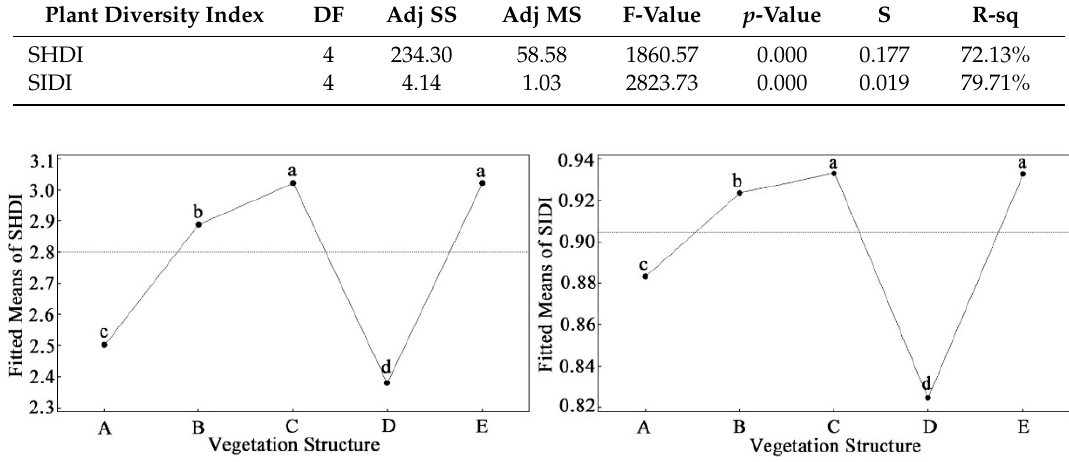
Figure 8. Differences of plant diversity index in green space with different vegetation structures. “A” represents open lawn green space, “B” represents semi-open lawn green space, “C” represents semi-closed single-layered broadleaved forest, “D” represents closed single-layered broadleaved forest, “E” represents closed single-layered mixed forest. The lower-case letters in the figure represent the grouping information obtained by multiple comparisons of means using the Tukey method.